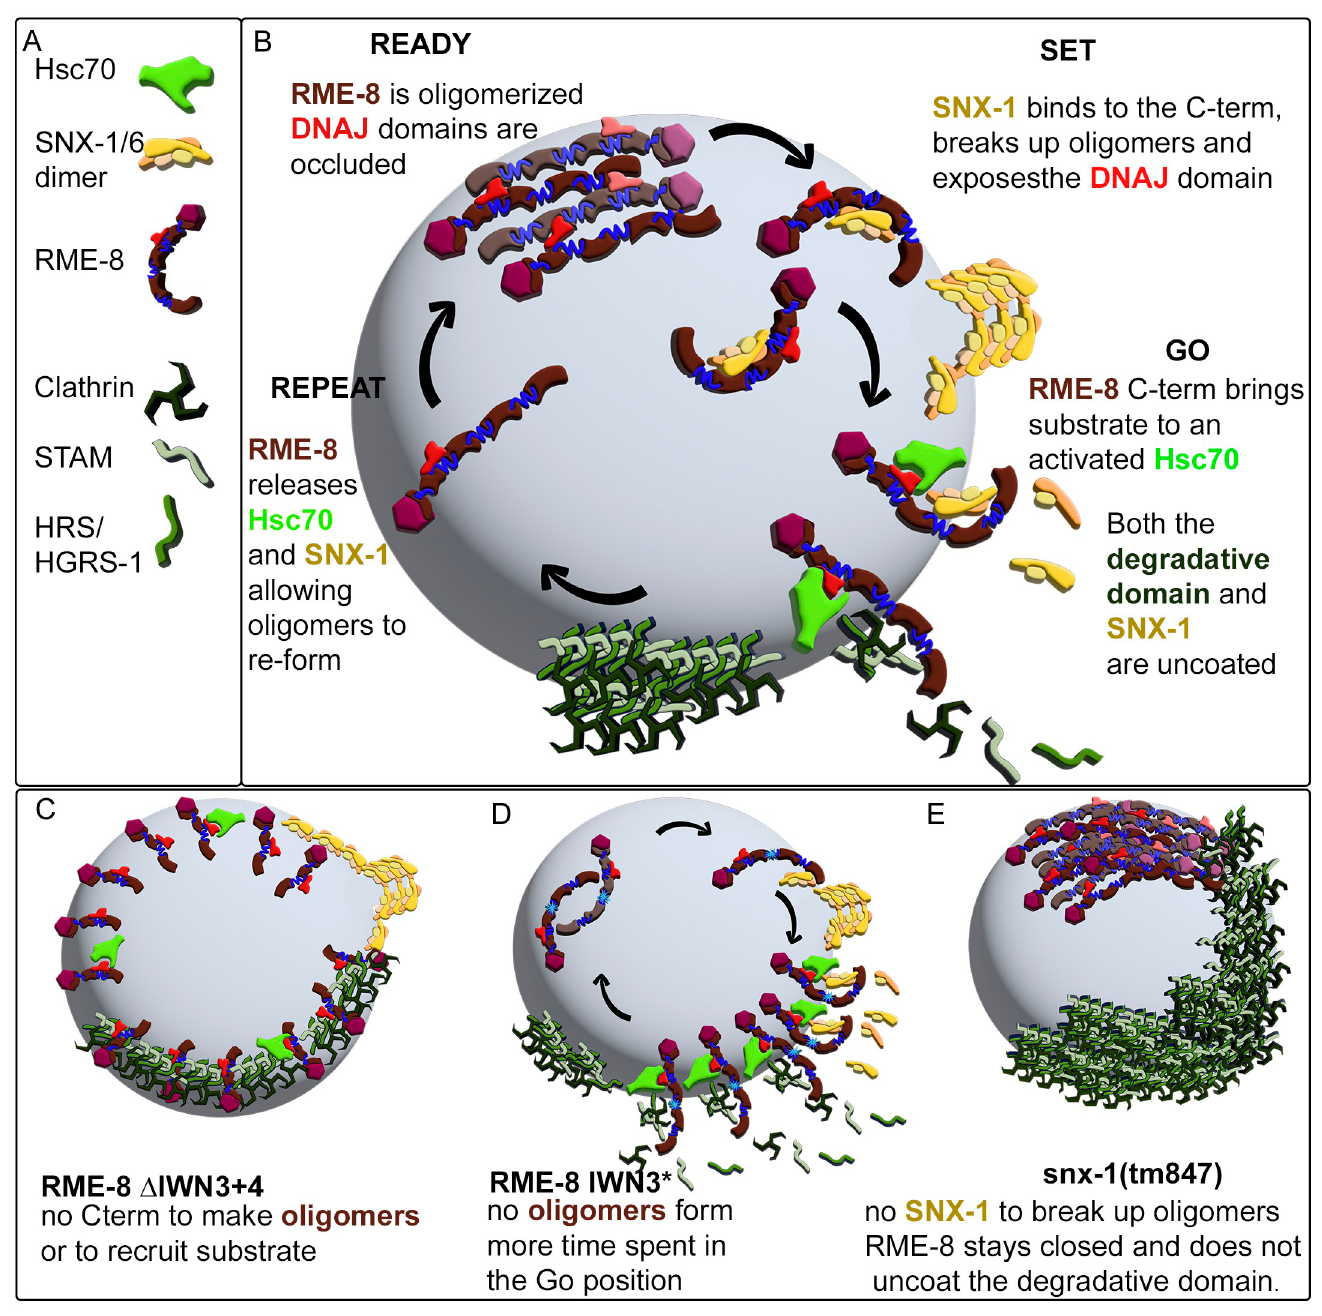
Fig 9. Ready Set Go model for cyclical activation of RME-8. (A) Legend (B) Illustration of the Ready Set Go Repeat model of cyclical RME-8 activation on the endosome. We propose that RME-8 exists in a few different states in the cell; an oligomerized inactive form with the DNAJ domain occluded (Ready), an open form bound to SNX-1 with the DNAJ domain exposed (Set). An active form bound by Hsc70 and substrate (Go). This model is informed by the idea that the RME-8 activator SNX-1 is also a target of RME-8 uncoating activity, allowing the process to be cyclical. (C) An illustration of the spread of RME-8 and accumulation of SNX-1 and HRS/ HGRS-1 in coelomcytes expressing RME-8 C-terminal truncations. (D) An illustration of the model for how the IWN3 � mutant disrupts RME-8 oligomers independently of SNX-1 allowing for more RME-8 to be in the active “go” state. (E) Illustration of the proposed HRS/HGRS-1 and RME-8 oligomeric accumulation that occurs in snx-1(0) animals as observed in previous studies